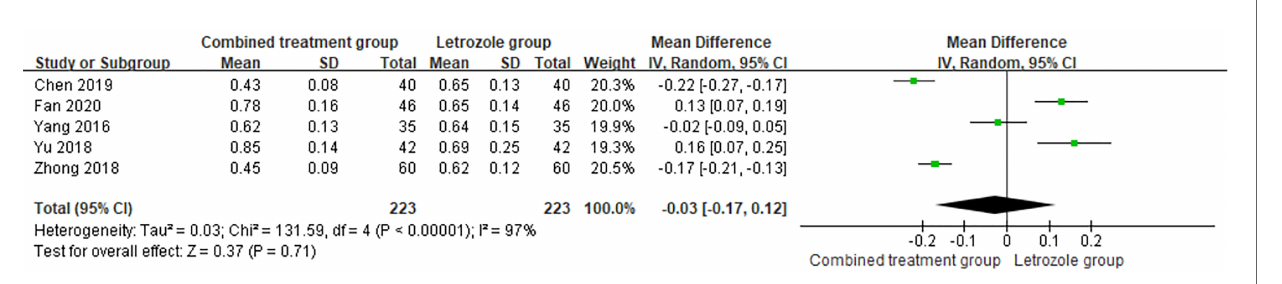
FIGURE 10 | Meta-analysis of the effect of Kuntai capsule combined with letrozole on progesterone (P) in polycystic ovary syndrome (PCOS)